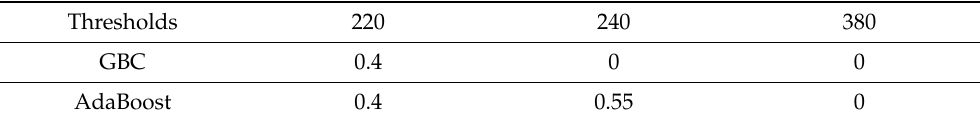
Table 6. Detecting an intoxicated instance with no errors: TPR (true positive rate) of classifiers with a fixed FPR (false positive rate) of zero. Thresholds